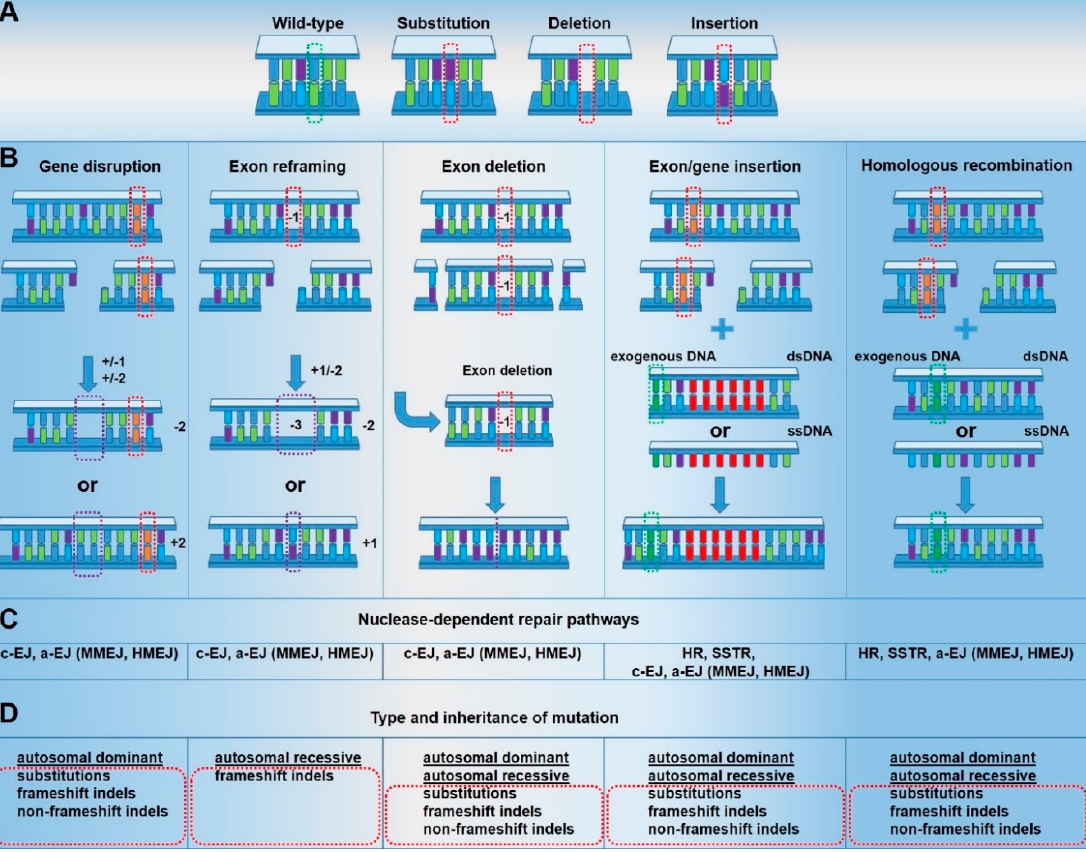
Figure 2. Context-dependent gene repair strategies. Genome editing technologies rely on the formation of specific double-strand breaks (DSBs) within a gene and their resolution via DSB repair pathways. The targeting strategy, nature, and context of the DSB determine the repair outcome of the different genome editing approaches. Therefore, the choice of an efficient targeting strategy for genome editing of genodermatoses is highly dependent on the type and inheritance of the mutation. ( A ) Types of mutations. ( B ) Gene repair strategies. ( C ) Nuclease-dependent DNA repair pathways. ( D ) Type and inheritance of mutation, which can be targeted by the respective gene repair strategy. (Orange bars and red dotted rectangles indicate the mutation site; dark green bars and dotted rectangles indicate wild-type (wt) sequence; purple dotted rectangles indicate wanted repair outcomes; red bars indicate exon/gene insertion.)